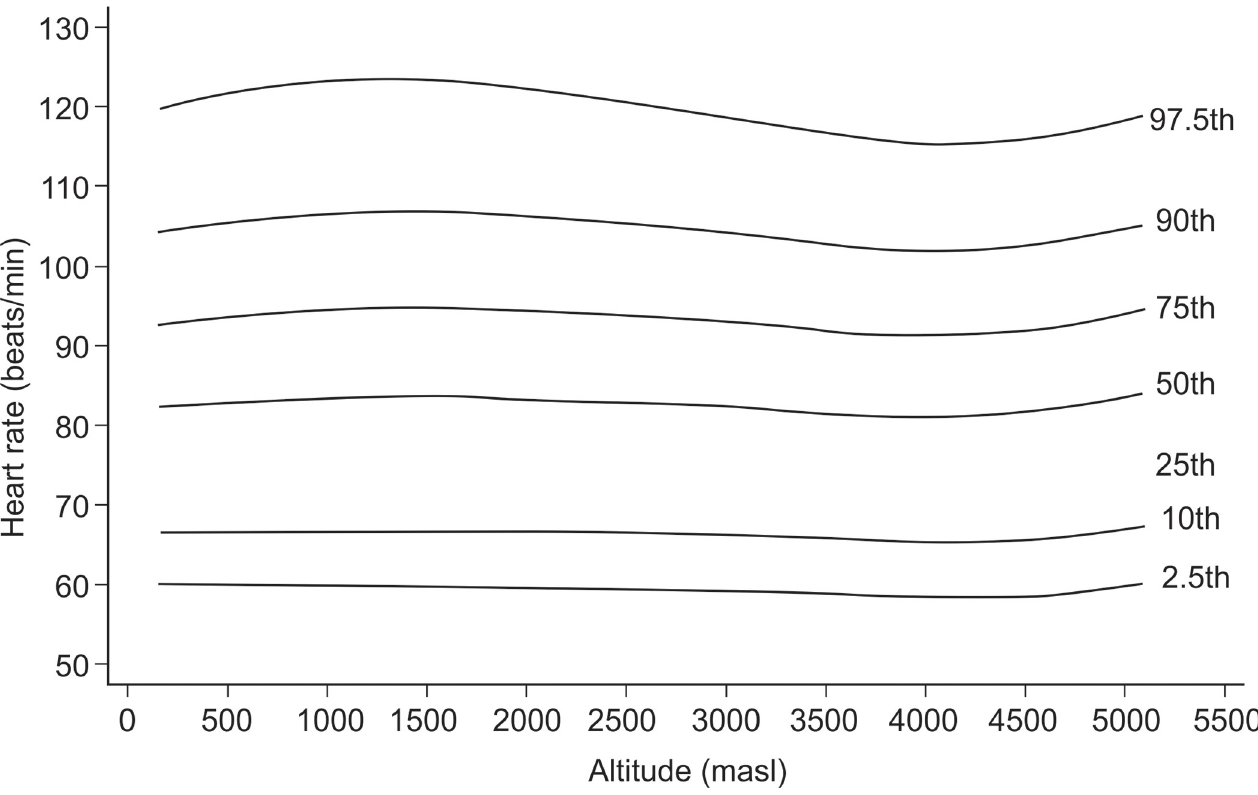
Fig 1. Heart rate at rest according to altitude of residence in Peruvian children of 1–5 years of age.